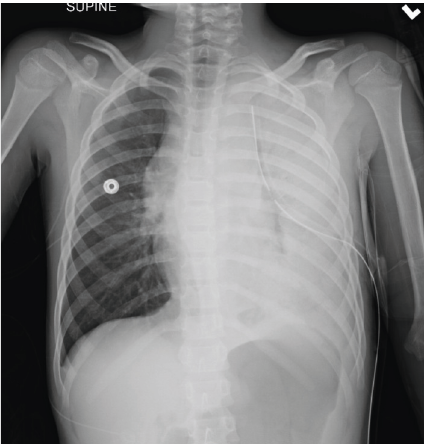
Figure 3: Immediate postchest tube thoracostomy chest radio- graph demonstrating resolution of the mass effect and midline